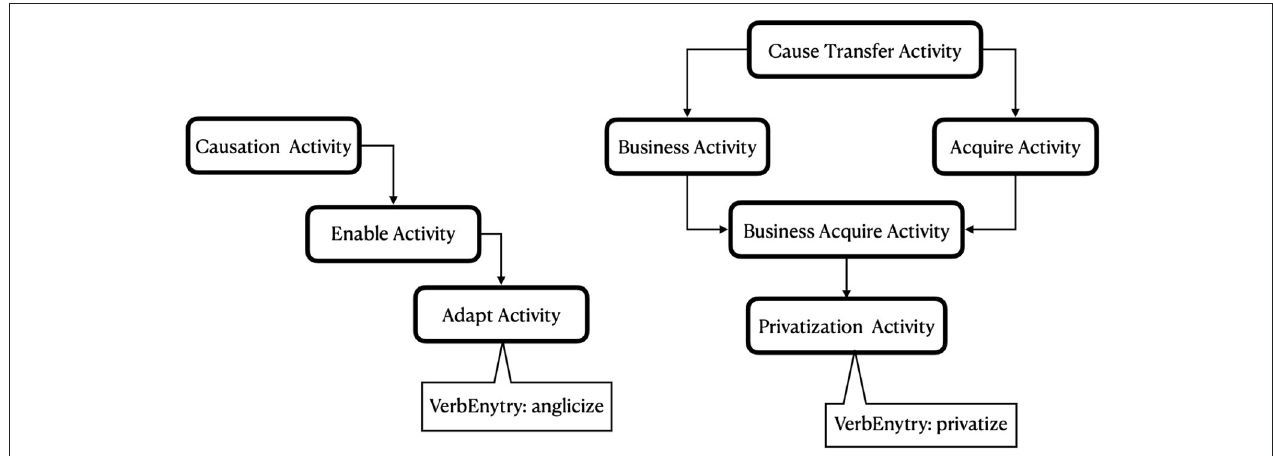
FIGURE 6 | Example of hierarchy in BSO types that illustrates distinct mappings to two members of the Other_cos-45.4 class: “anglicize” and “privatize”.